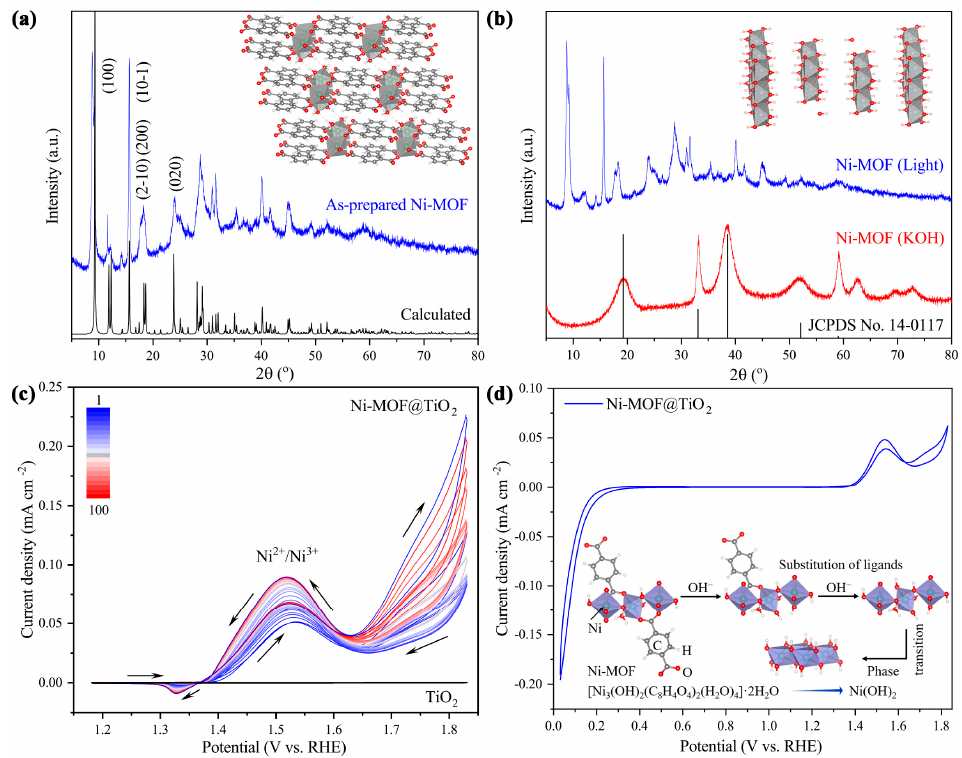
Figure 6. ( a ) Calculated and experimental XRD patterns of as-prepared Ni-MOF powder. Inset: crystal structure of Ni-MOF. ( b ) XRD of Ni-MOF powder treated under AM 1.5G illumination and in the 1 M KOH/0.33 M urea solution. Inset: crystal structure of β -Ni(OH) 2 . ( c , d ) CV curves of Ni-MOF@TiO 2 electrode measured in the electrolyte of 1 M KOH/0.33 M urea and in the dark. Scan rate: 100 mV s − 1 . Inset of ( d ): probable transition mechanism of Ni-MOF.